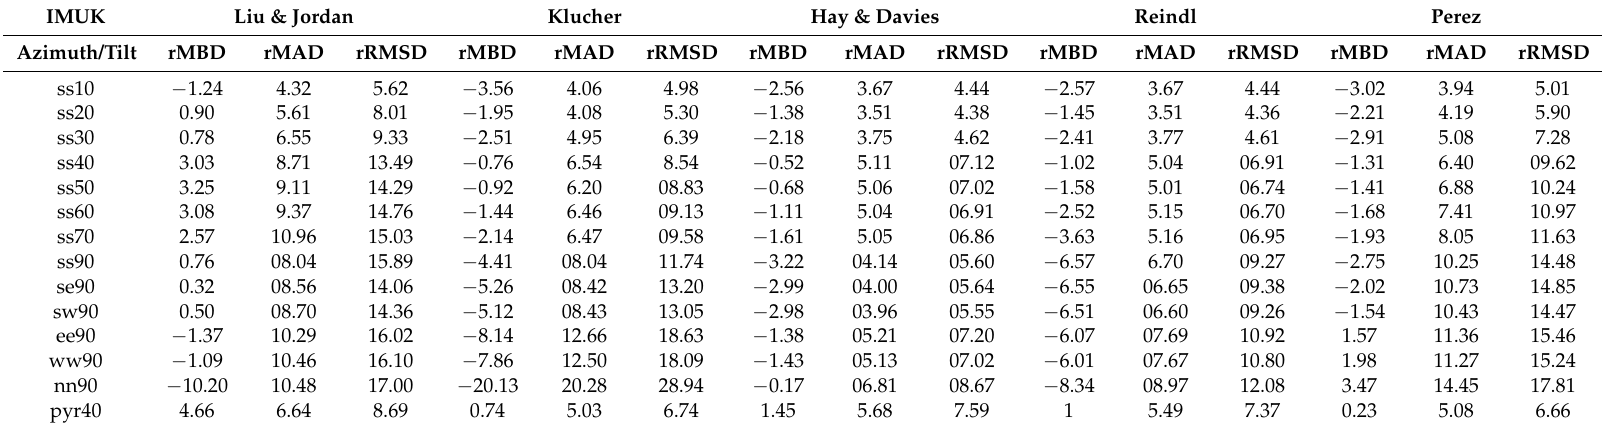
Table 4. Performance of all five transposition models, compared to IMUK measurements.